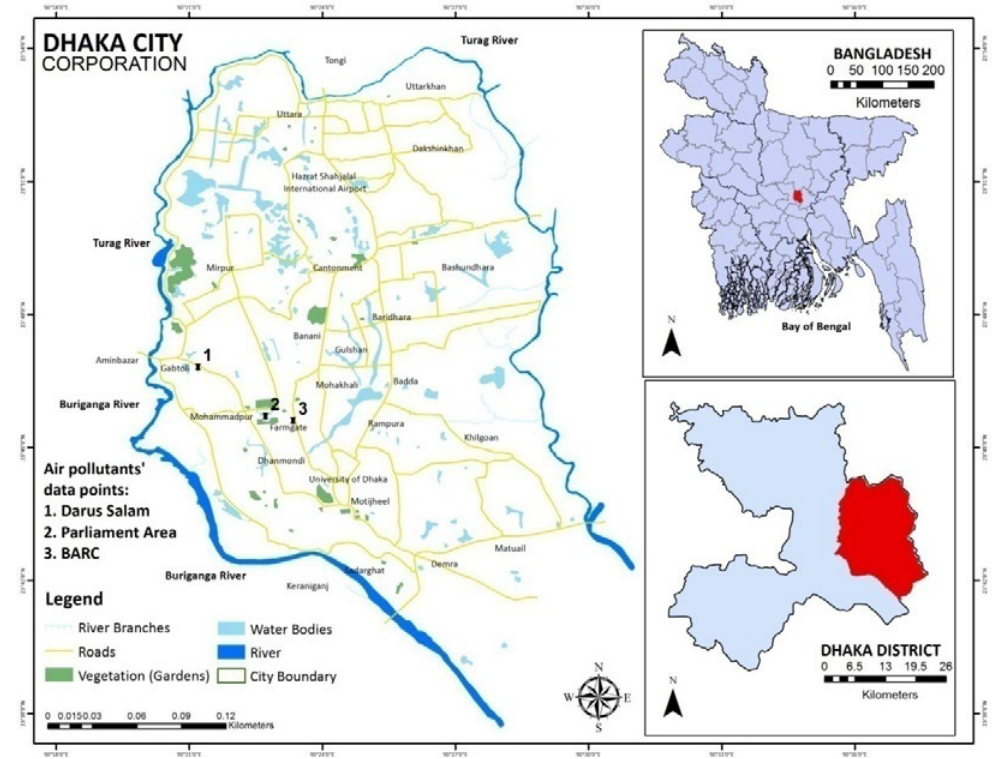
Fig. 1. The geographic location of the study area showing the Continuous Air Monitoring Stations (CAMS) installed in Dhaka City, Bangladesh